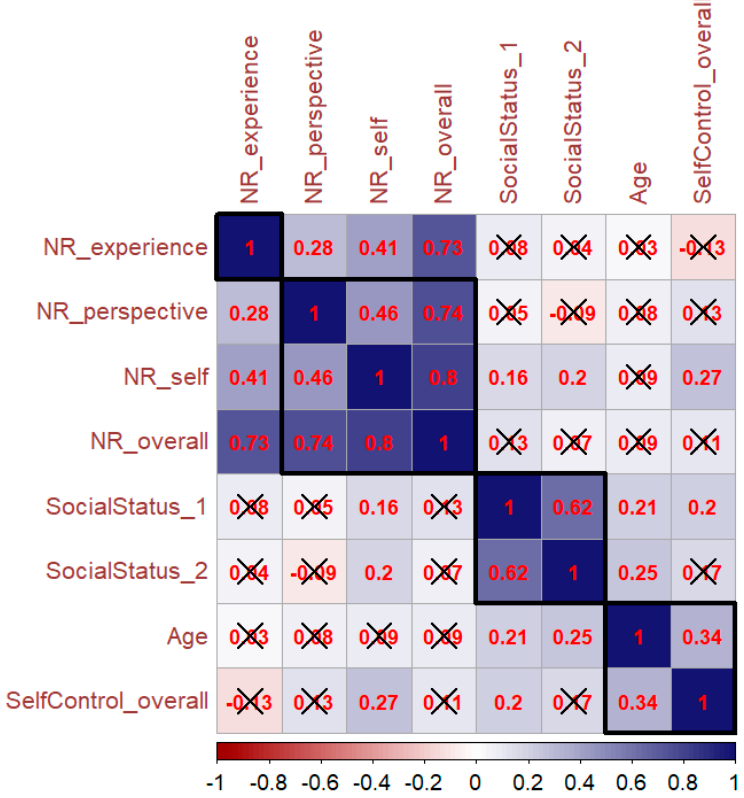
Figure 4. Correlation between NR components and chosen metric variables (women).